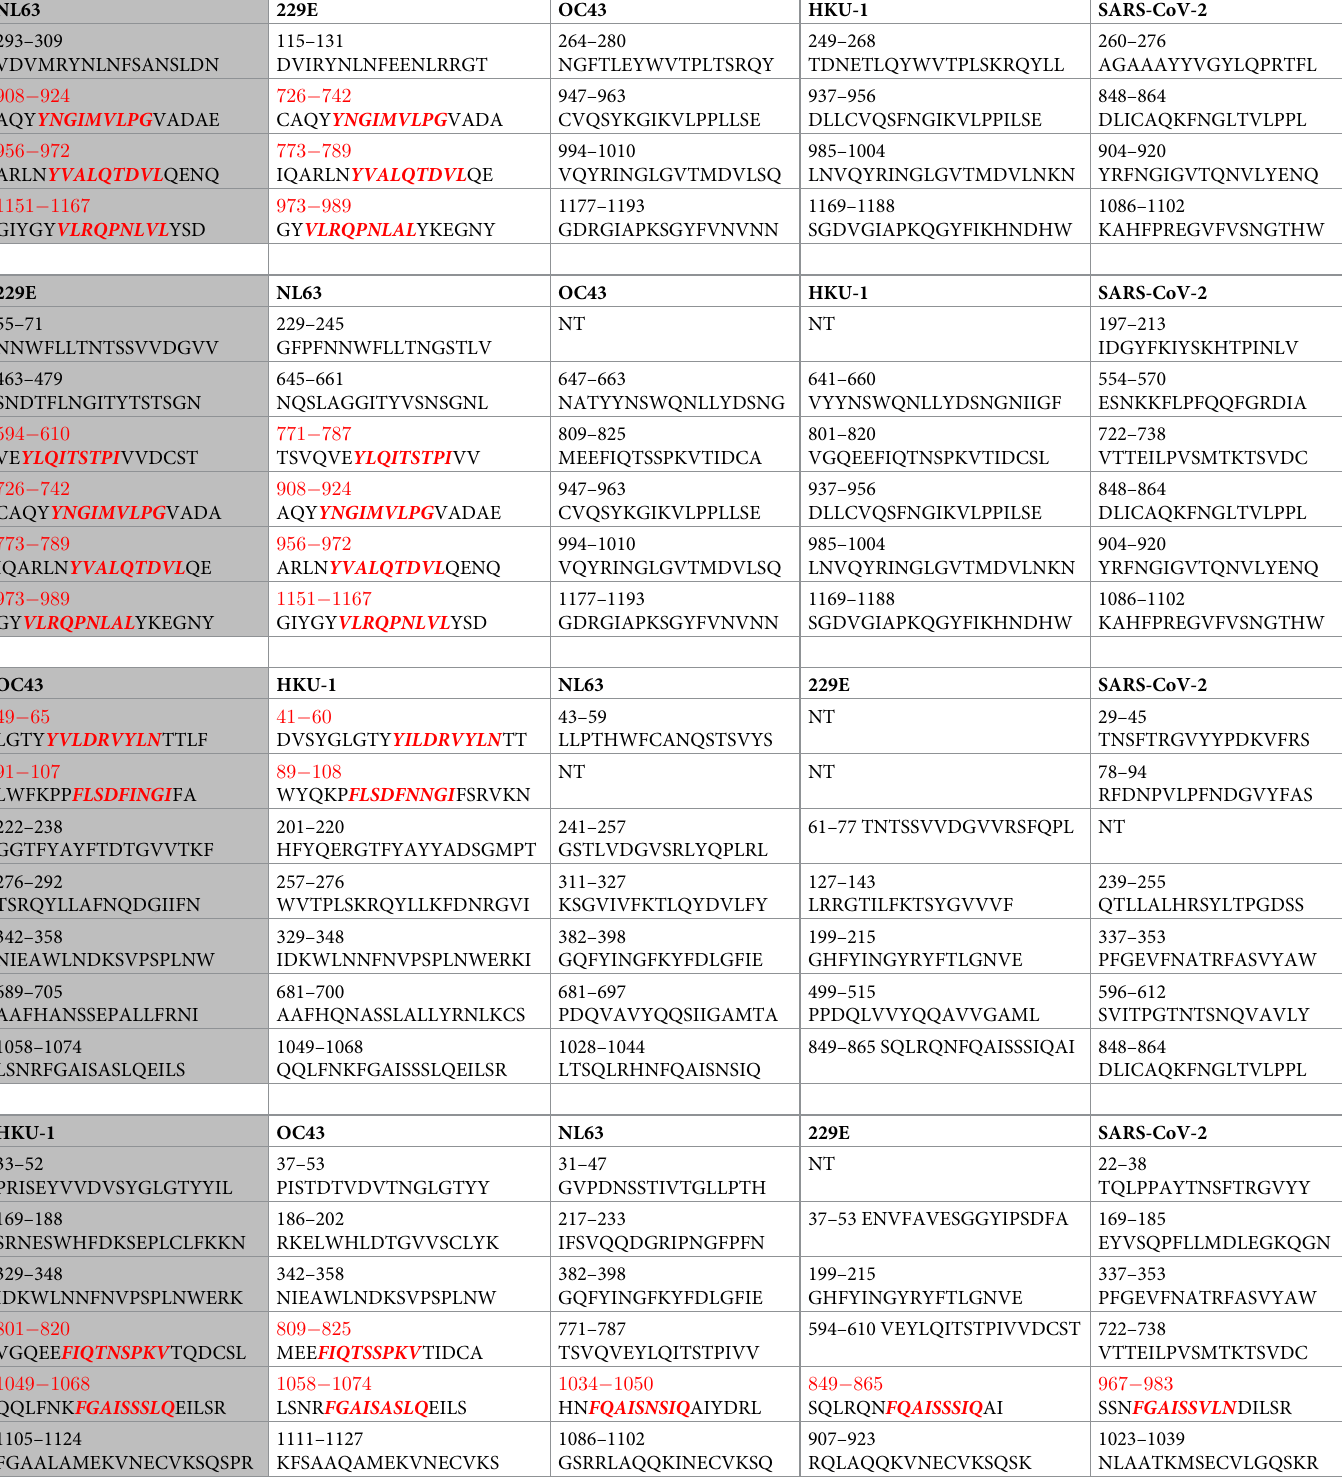
Table 3. Potential DR0401 restricted ccCoV cross-reactive epitopes identified in CD154 assay. Red indicates cross-reactive epitopes. Bold and italic red indicates the putative MHC-II binding motif as predicted by NetMHCII pan 4.0. Shaded grey column indicates the cell line generated from PBMCs stimulated with listed epitope and ccCoV. NT: not